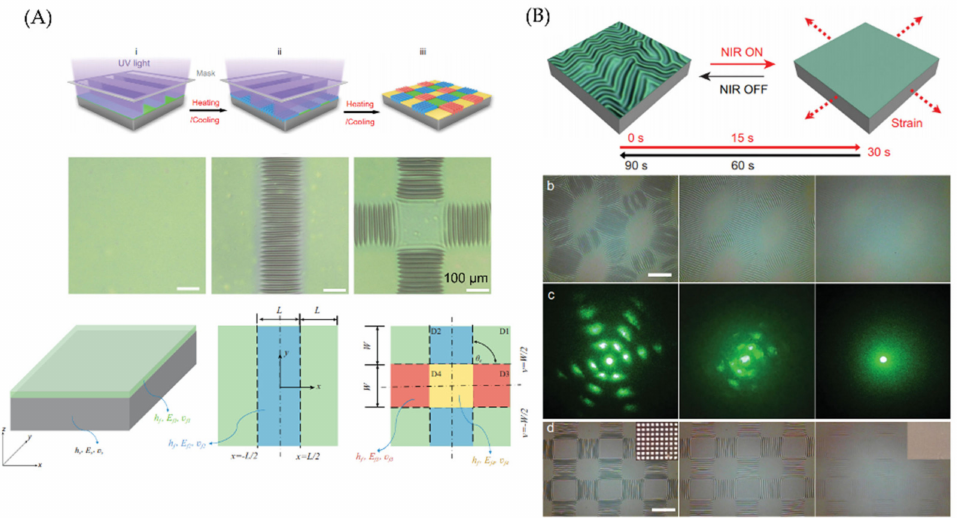
Figure 7. ( A ) Schematic representation of the light-controlled wrinkled pattern fabrication process via a lithographic approach, using 365 nm sequential UV from a 200 µ m strip array photomask. ( B ) Illustration of the NIR-driven ordered wrinkles serving as a dynamic light grafting. (b) Opti- cal images of the wrinkle disappearance/regeneration process by the NIR on/off switch. (c) The corresponding light diffraction patterns. (d) Optical images of Au-functionalized wrinkle disappear- ance/regeneration process by NIR on/off switch. Reproduced with permission from reference